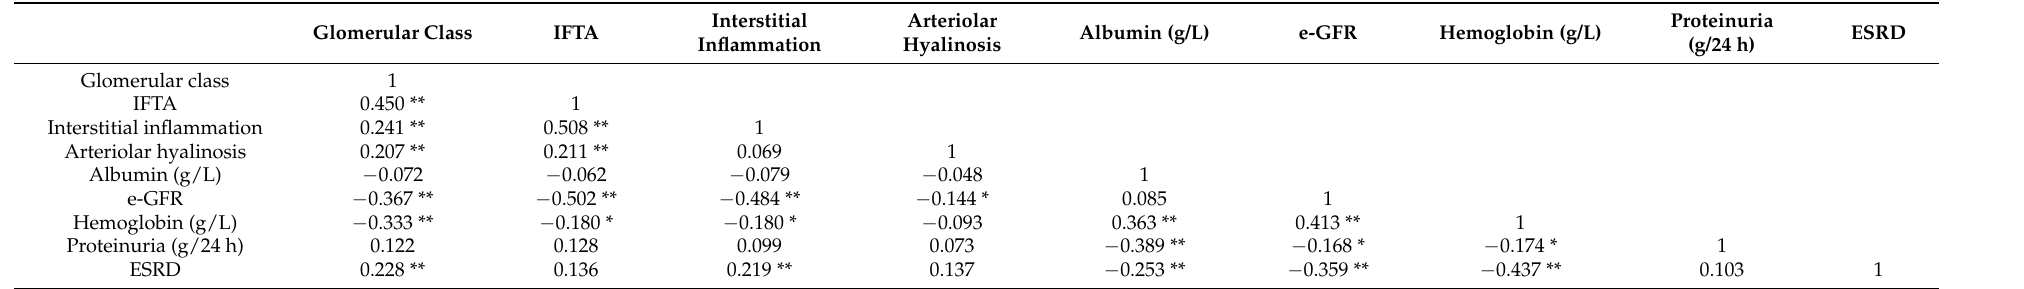
Table 4. Correlations between the histopathological and clinical